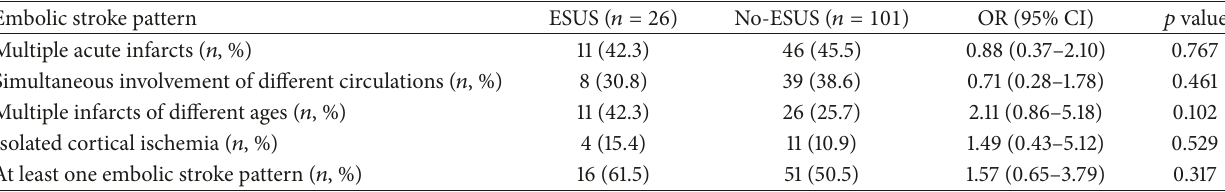
Table 2: Association between embolic stroke patterns and the diagnosis of embolic stroke of undetermined source at baseline ( 𝑛 = 127 ). Embolic stroke pattern